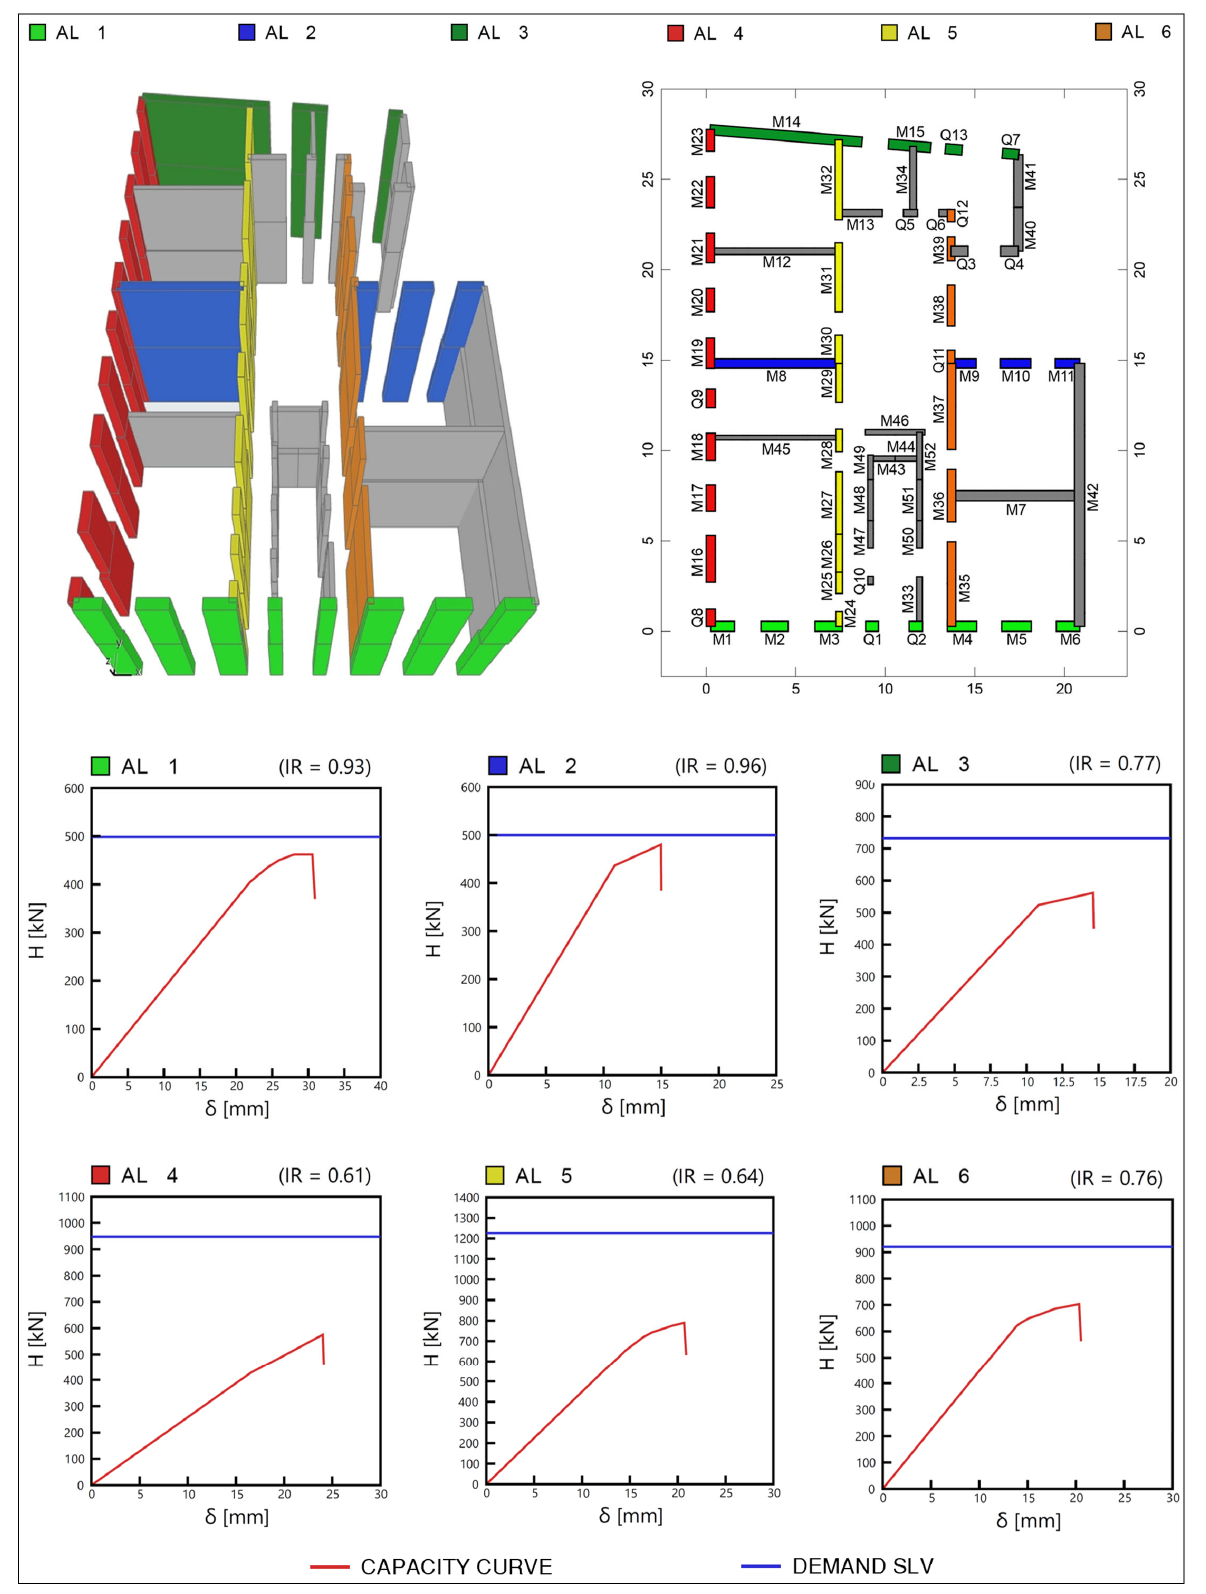
Figure 11. Capacity curve and seismic demand plotted for each alignment of the “Bernardo Rucellai” school in Rhinoceros.